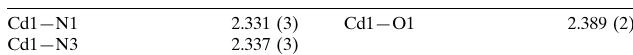
Selected bond lengths (A˚ ).